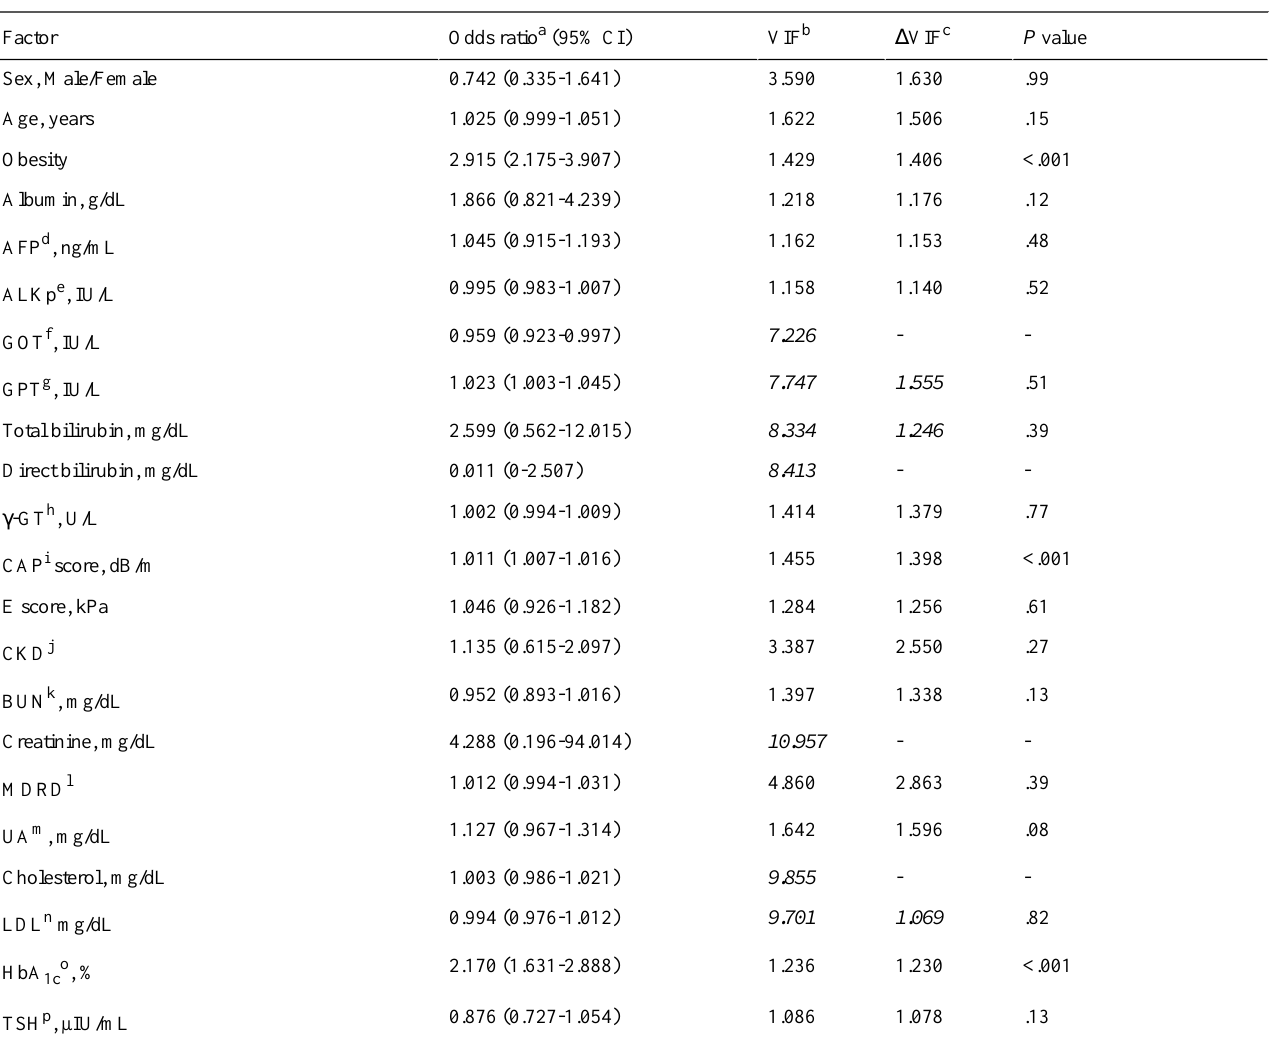
Table 2. Multivariate logistic regression analysis of risk factors related to metabolic